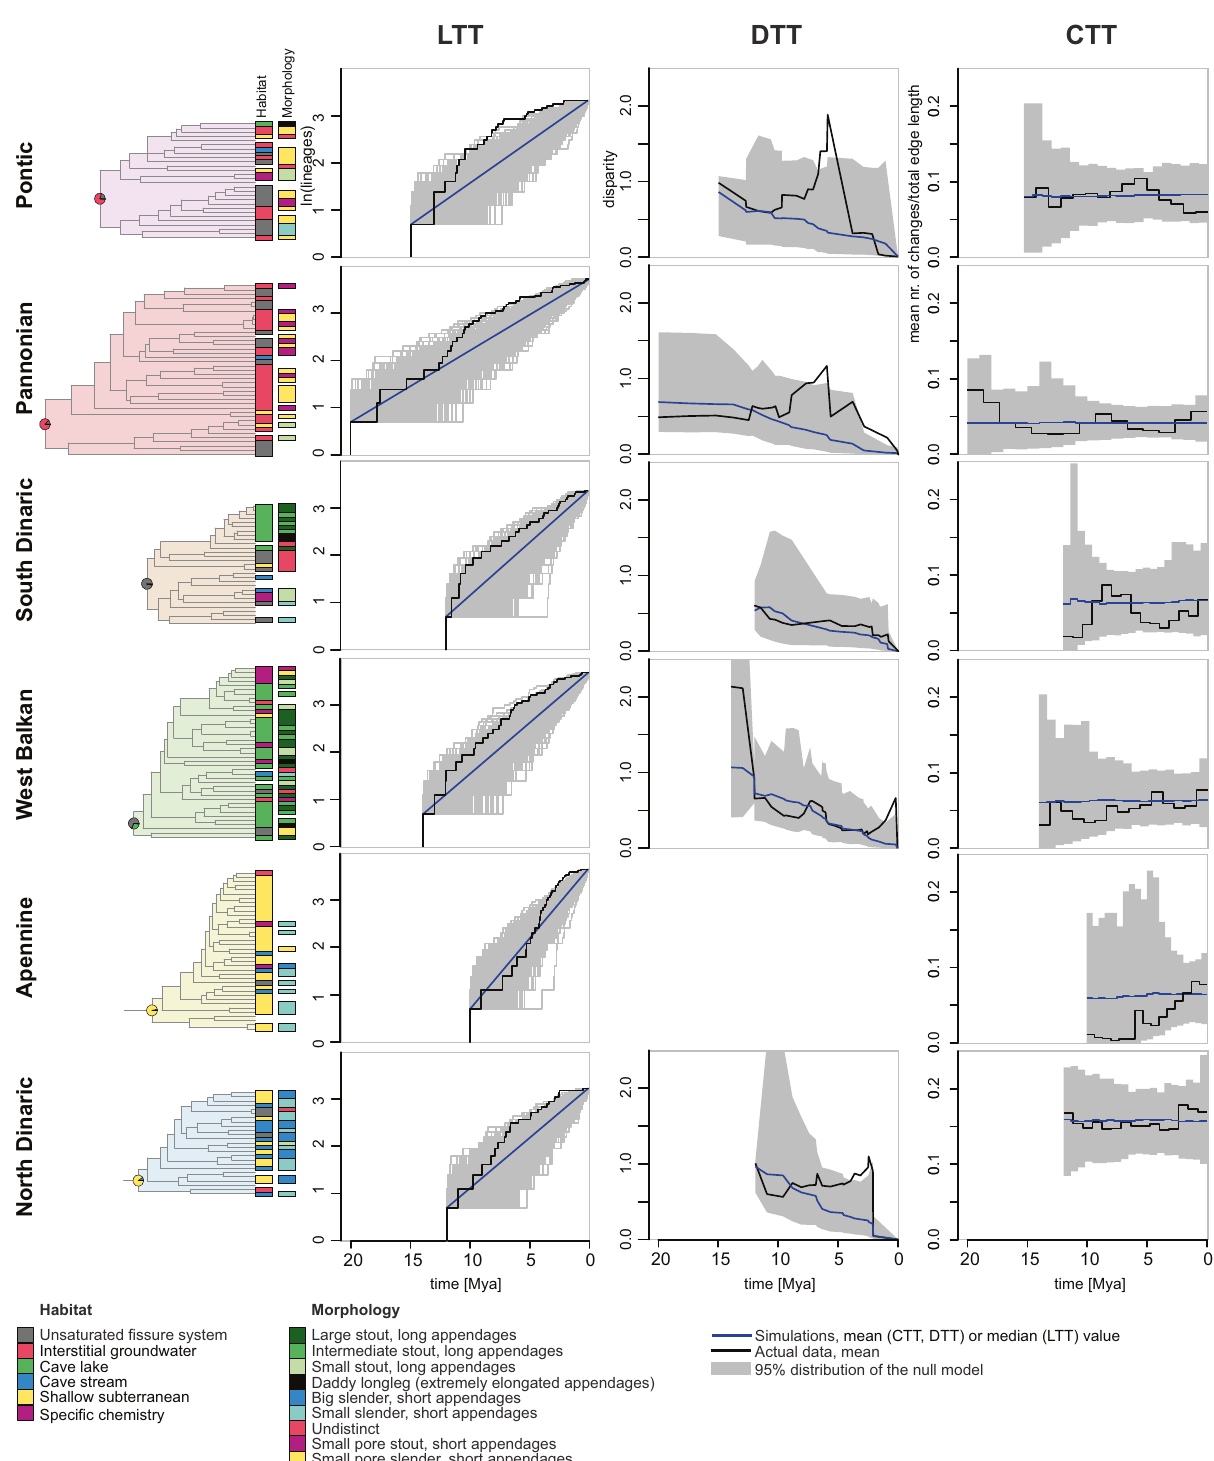
Fig. 4 Evolution of six major Niphargus subclades. Zoomed phylogenies with plotted habitats and morphotypes (missing data not available), lineage through time (LTT), changes through time (CTT) and disparity through time (DTT) plots. The DTT analysis could not be performed for the Apennine clade due to too much missing